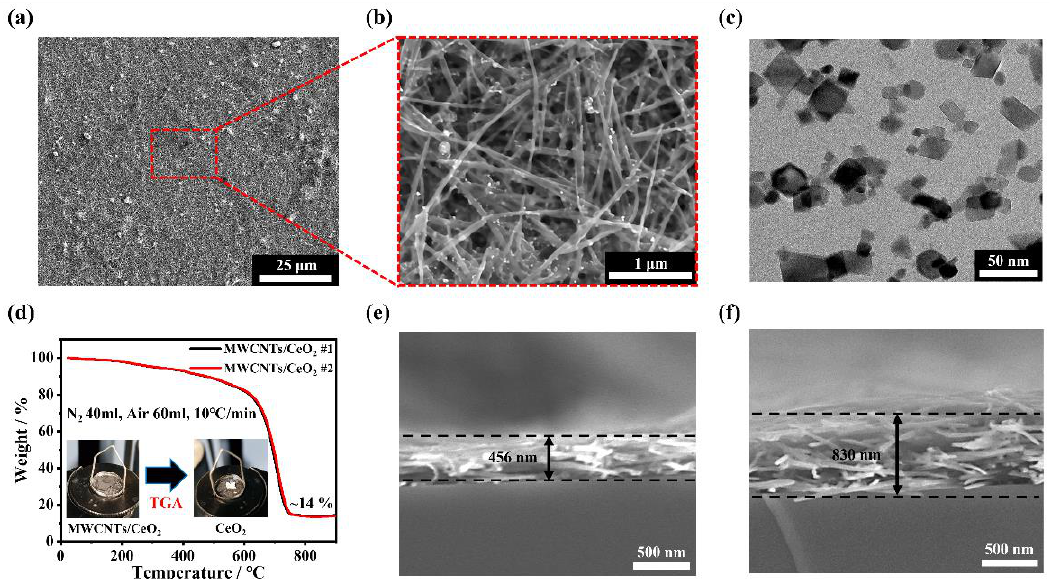
Figure 2. SEM surface images of the MWCNTs/CeO 2 without the Nafion ionomer with magnification at ( a ) 1 k and ( b ) 30 k. ( c ) TEM image of the CeO 2 nanoparticles. ( d ) TGA results of the MWCNTs/CeO 2 . Cross-sectional SEM images of the MWCNTs/CeO 2 with thicknesses of ( e ) 450 nm and ( f ) 830 nm.